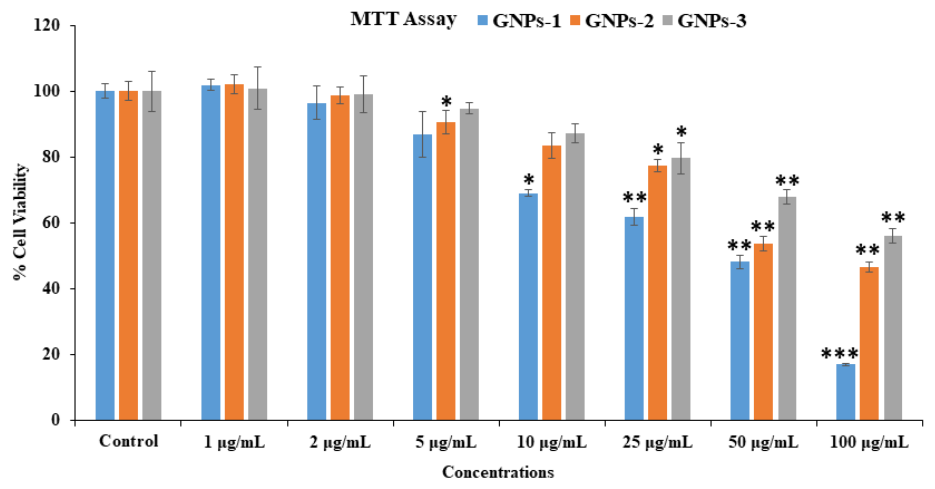
Figure 5. Cytotoxicity assessments by MTT assay in HepG2 cells after the exposure of GNPs-1, GNPs-2, and GNPs-3 at different concentrations for 24 h. The values are mean ± SE of three independent experiments. * p < 0.05, ** p < 0.01, and *** p < 0.001 vs. control.